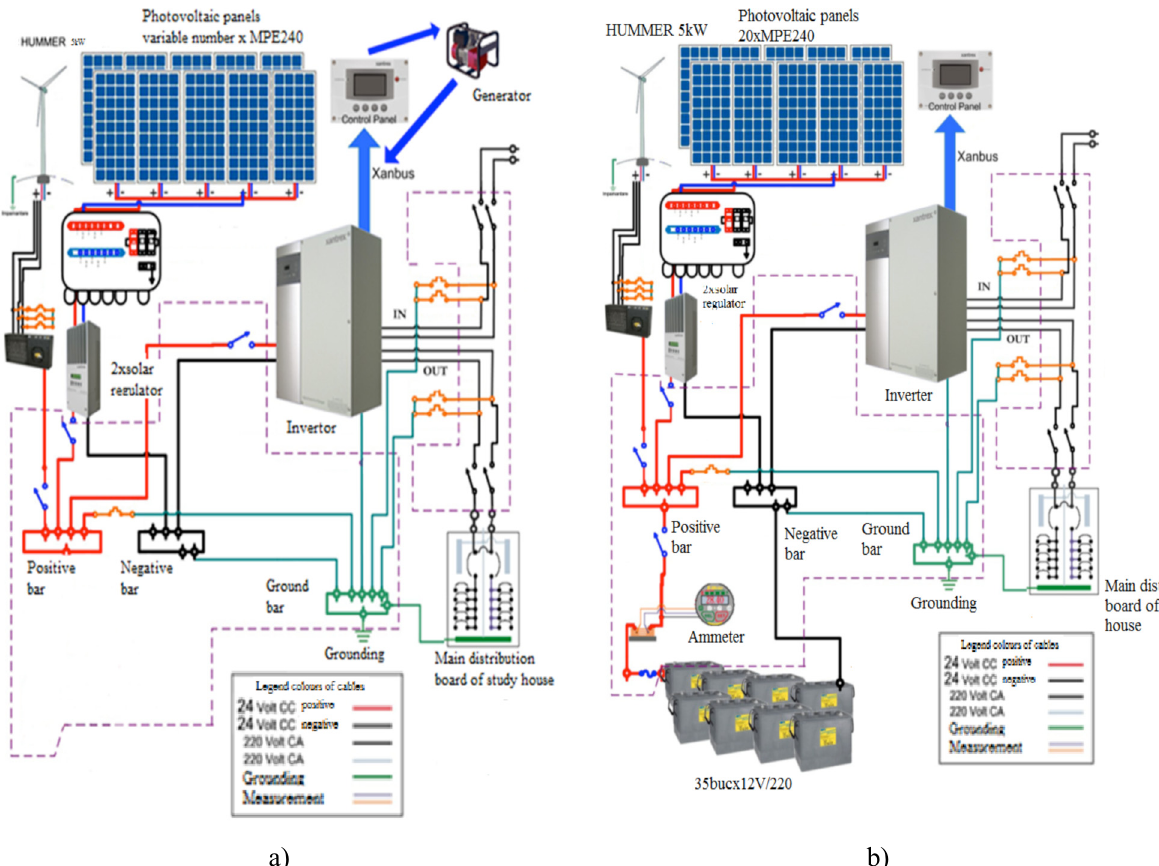
Fig. 3. Working options chosen: (a) solution one with generator, (b) solution two